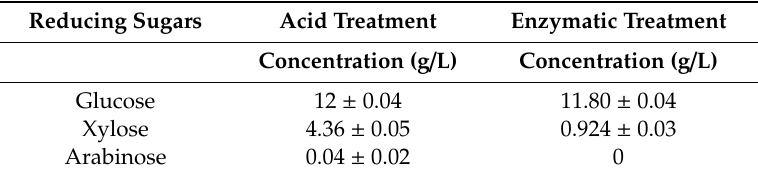
Table 4. Compositional analysis of reduced sugars after acid and